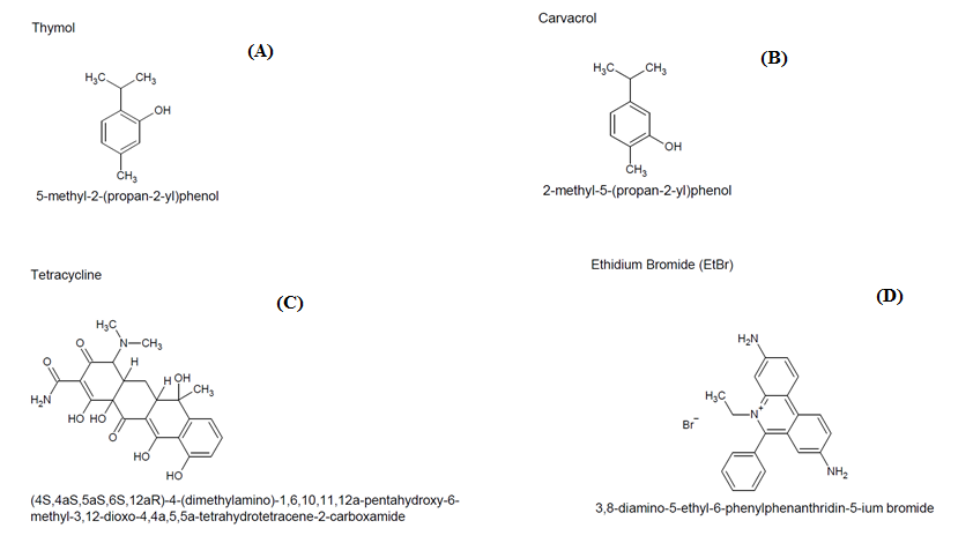
Figure 5. Chemical structures of thymol ( A ), carvacrol ( B ), tetracycline ( C ) and ethidium bromide ( D ).